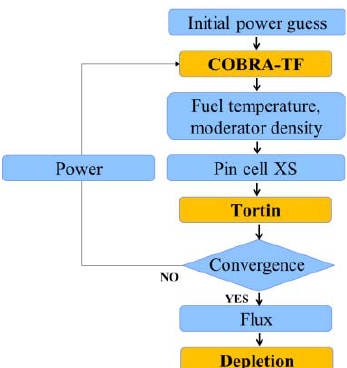
Figure 1. Calculation scheme of